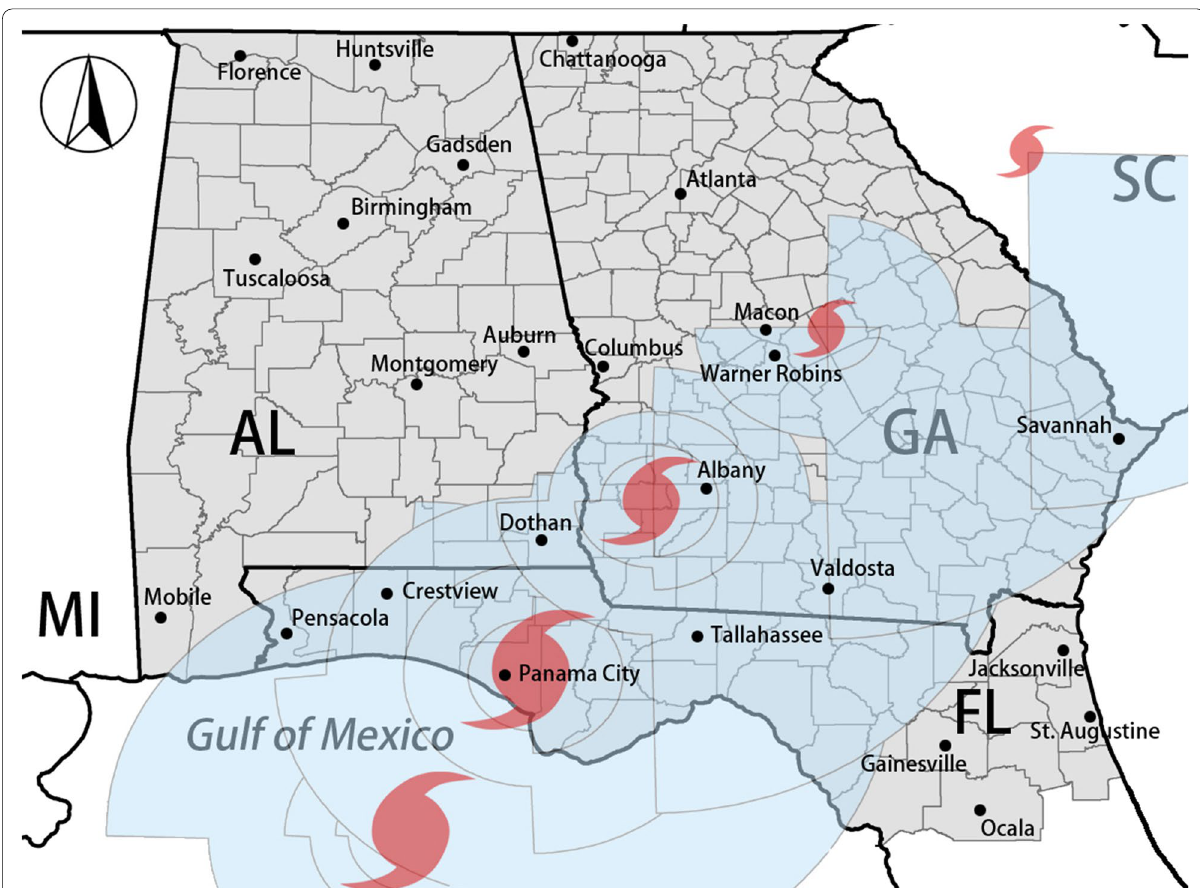
Fig. 3 Study area and the impacted area of Hurricane